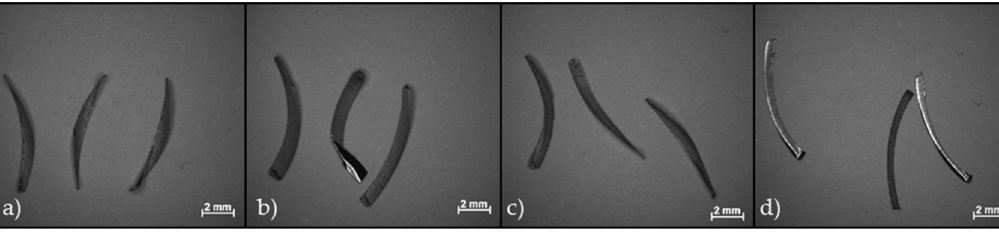
Figure 14. Averaged temperature curves during the machining process.